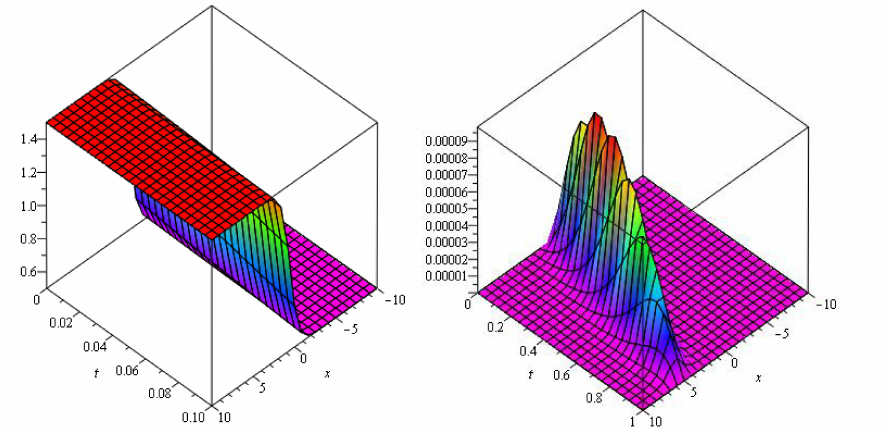
Figure 5. Graphs of µ ( ζ , τ ) and error plot at ρ = 1 of example 3.